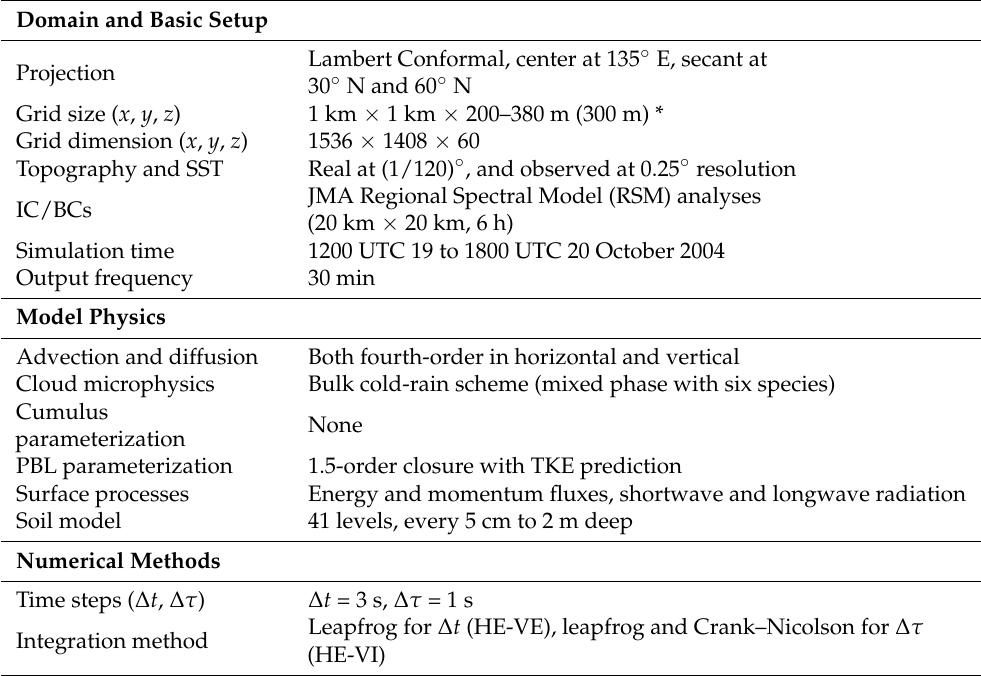
Table 1. Summary of CReSS-model configuration of domain and basic setup, physics, and numerical methods used in this study. The time integration schemes can be classified as horizontal explicit (HE), vertical explicit (VE), and vertical implicit